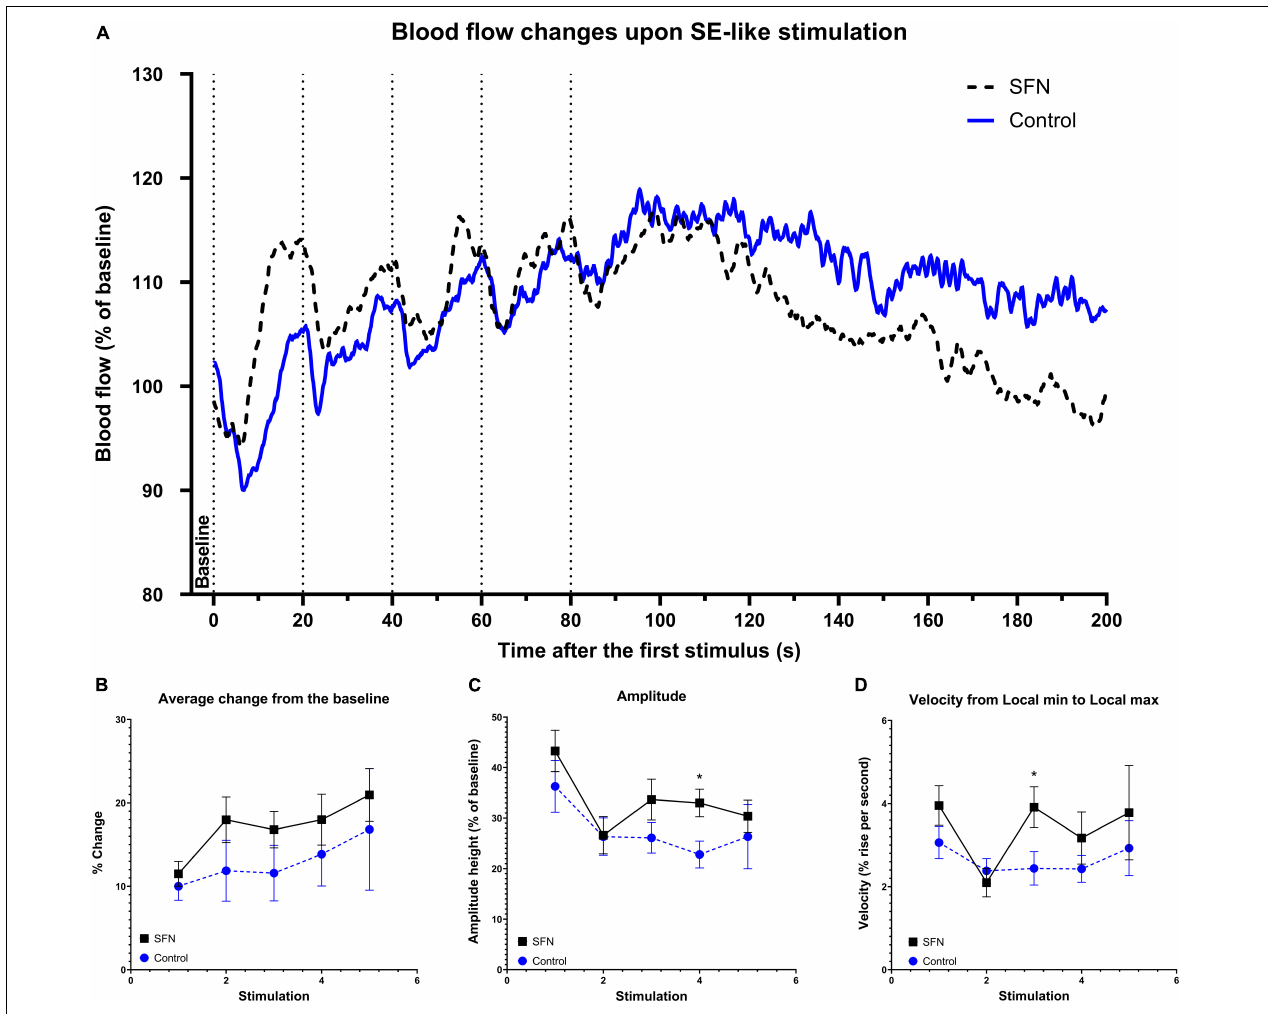
FIGURE 8 | SFN pretreatment improved blood flow response to SE-like stimulation. Dotted lines (A) denote the beginning of each 20 Hz stimulation lasting 10 s. These 5 rapid consecutive stimulations with no given time to full recovery were used to simulate a SE-like impact on the blood flow. Baseline was calculated as average of values from 5 s before the first stimulation to its onset. The average trace of the group at any given time (smoothed) for each frequency and group is shown panel (A) . Parameters that had shown SFN as a significant factor (two-way ANOVA) are shown panels (B–D) . We observe the increased average change from the baseline (B) increased amplitude (C) and increased velocity to cover the amplitude (D) . Multiple unpaired t- tests were run to compare values at each stimulus, significant results are denoted by an asterisk. All values (B–D) are reported as mean ± SEM (* P <